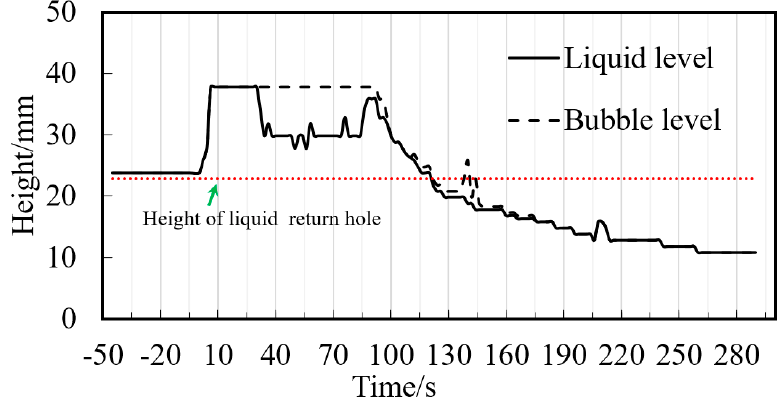
Figure 7. Variations of liquid level in the accumulation during startup.